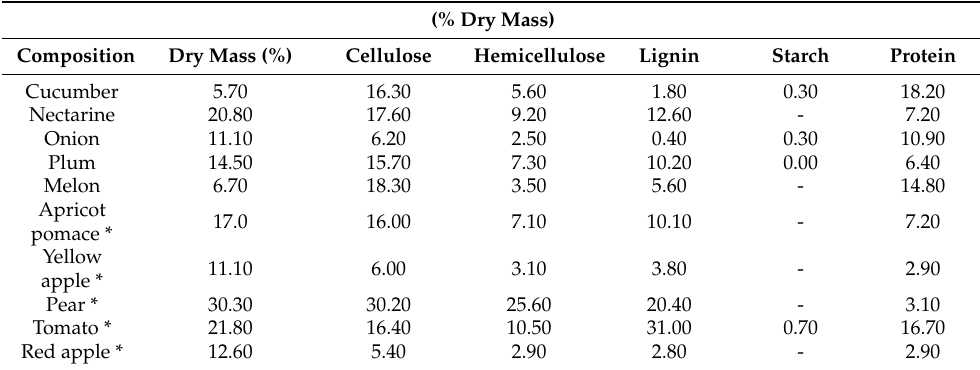
Table 1. Chemical content (% of dried matter) of agricultural wastes considered in this work. Wastes labeled by * originated from industrial processes. (% Dry Mass)